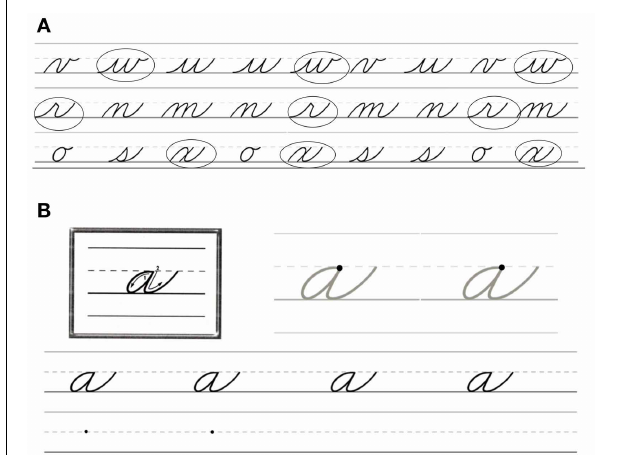
FIGURE 2 | (A) An example of the cursive letter pre-test: participants circle each instance of a letter given to them. (B) An example of the worksheets used for learning to write cursive